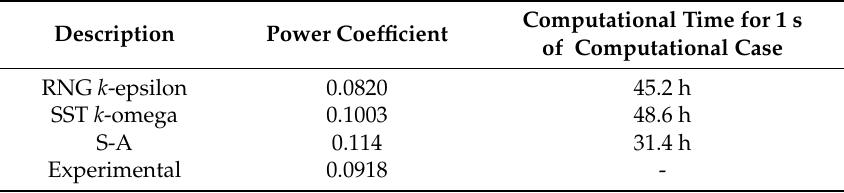
Table 2. Numerical and experimental